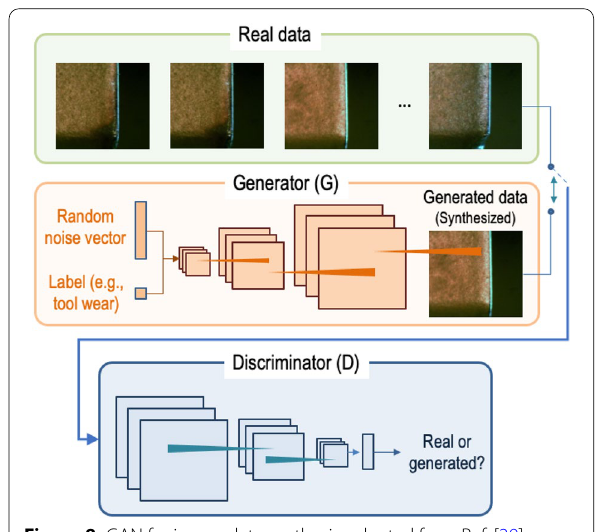
Figure 8 GAN for image data synthesis, adapted from Ref.